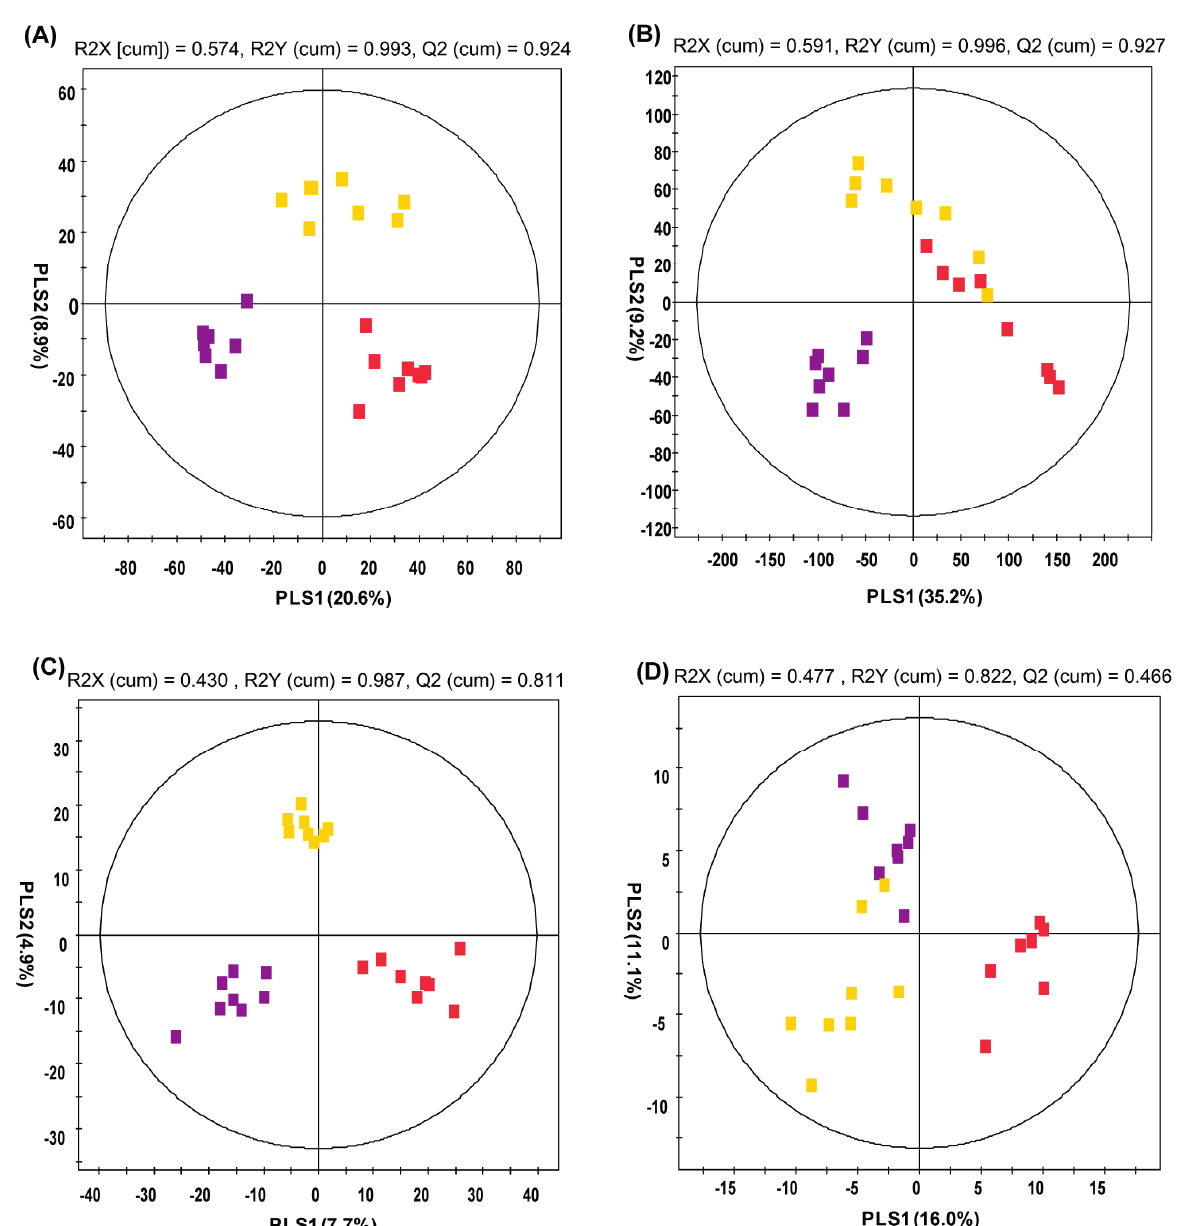
Figure 1. Partial least-squares discriminant analysis (PLS-DA) score plots. Urine analysis by ( A ) UPLC-Q-TOF-MS and ( B ) GC-TOF-MS. Serum analysis by ( C ) UPLC-Q-TOF-MS and ( D ) LTQ-XL-MS. ( ■ : normal diet; ■ : high-fat diet, ■ : high fat diet with